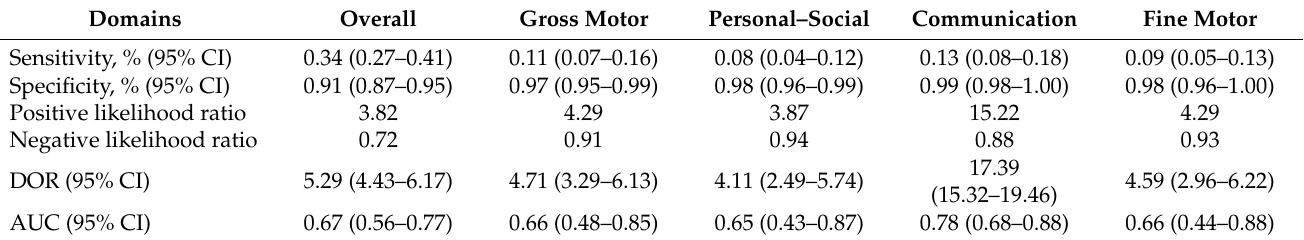
Table 3. Classification performance of the Ages and Stages Questionnaire—Third Edition.